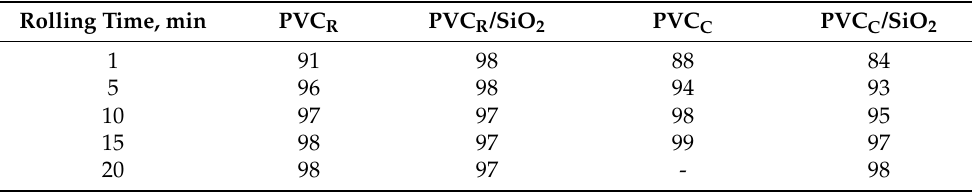
Table 1. Degree of gelation (%) of PVC R and PVC C and PVC nanocomposites with SiO 2 . Rolling Time, min